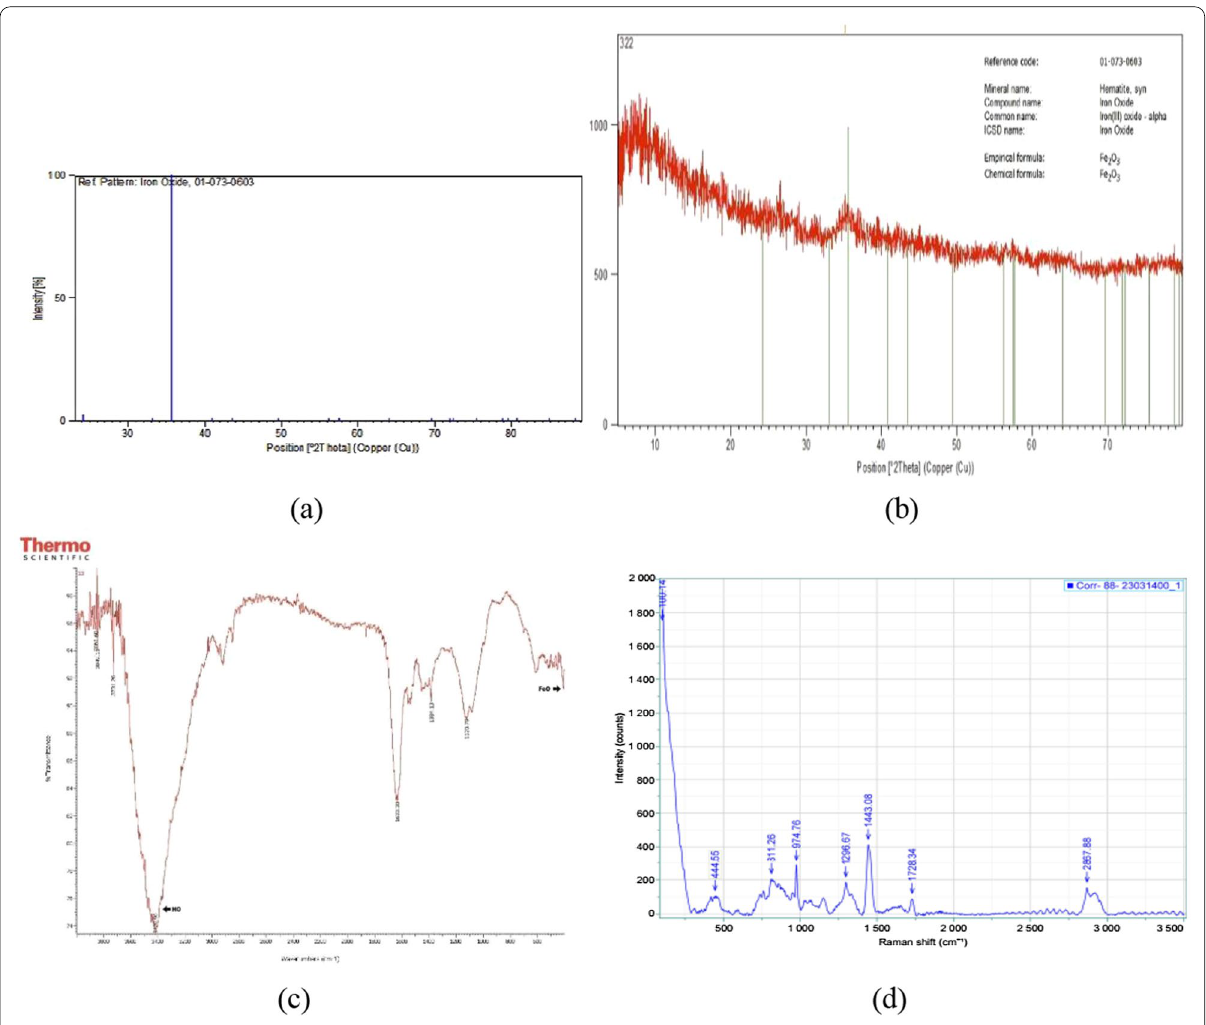
Fig. 3 a , b X-ray diffraction (XRD) pattern for the suspension containing iron oxide, c Fourier-transform infrared spectroscopy (FTIR), d Raman